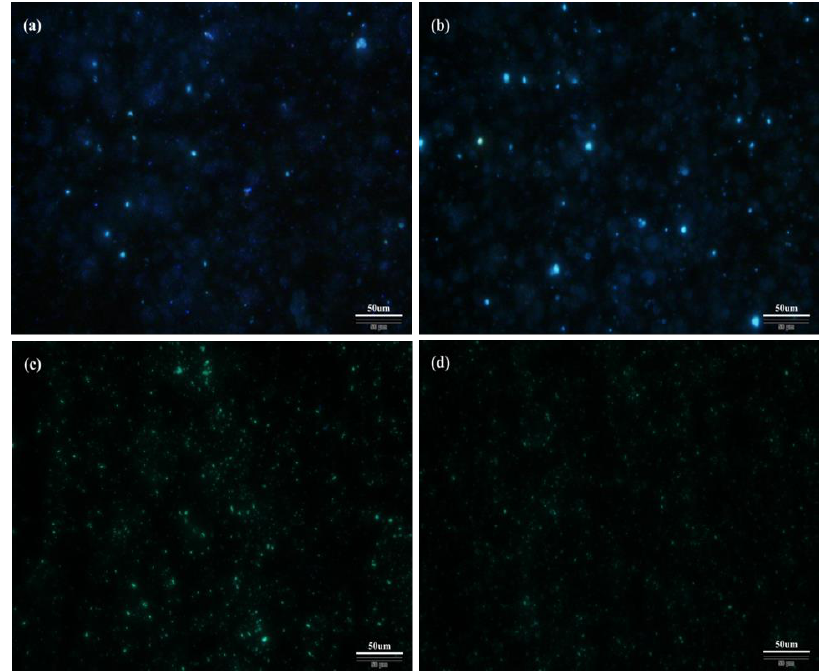
Figure 9. Fluorescence microscope images of the coating before and after the pollutant was removed: before pollutant coated ( a ) after conversion, ( b ) after FAS-17 modification; after pollutant removed ( c ) before FAS-17 modification, ( d ) after FAS-17 modification.